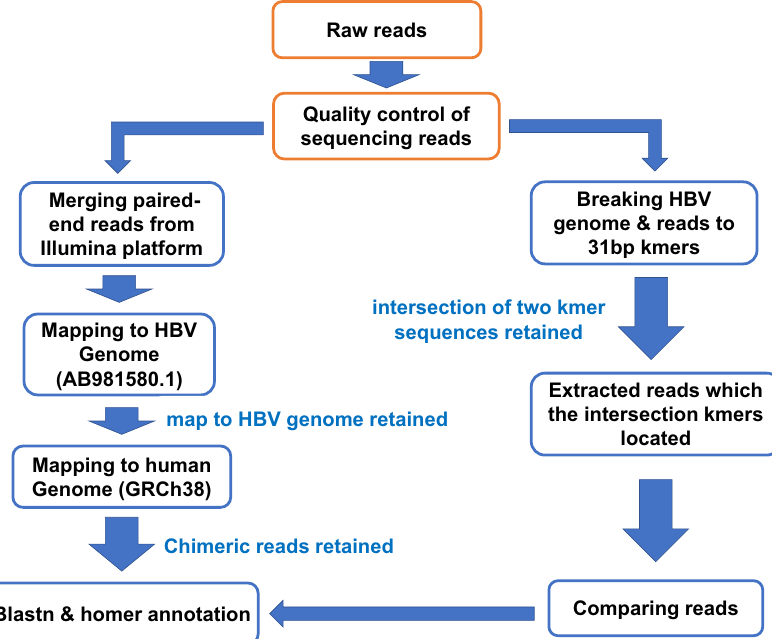
Fig. 1 Work fl ow of HBV integration analysis. The raw data were fi rst mapped to the HBV genotype C genome using BLAST. Reads mapped to the HBV genome were retained using local scripts and then mapped to the human genome. To verify the reliability of this work fl ow in detecting chimeric reads of HBV integration, another pipeline was used to compare the consistency of these two